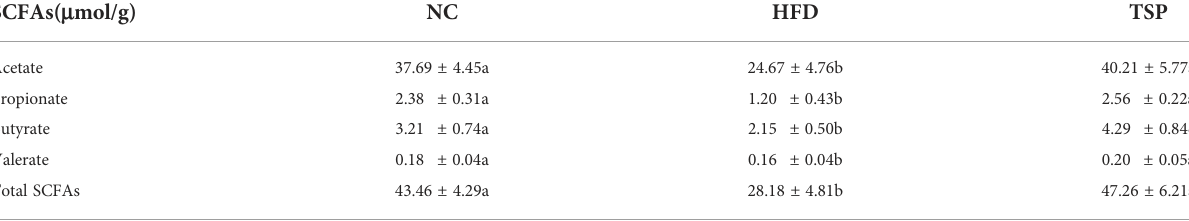
Signi fi cant differences ( p < 0.05) are indicated using different letters (a, b, c)